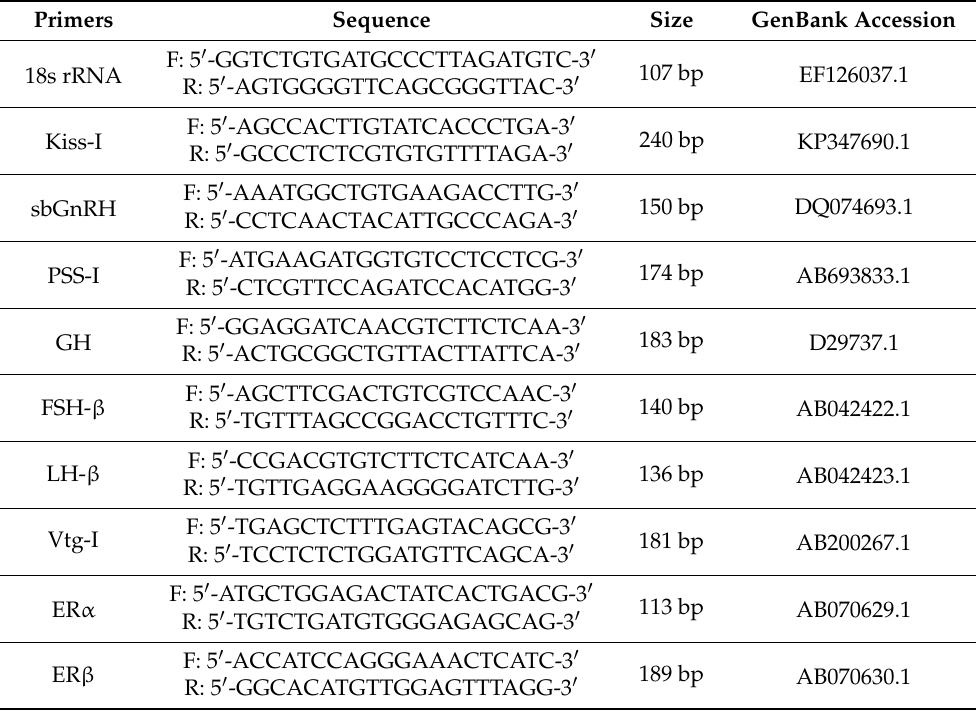
Table 3. Primers used for real-time qPCR (qPCR)